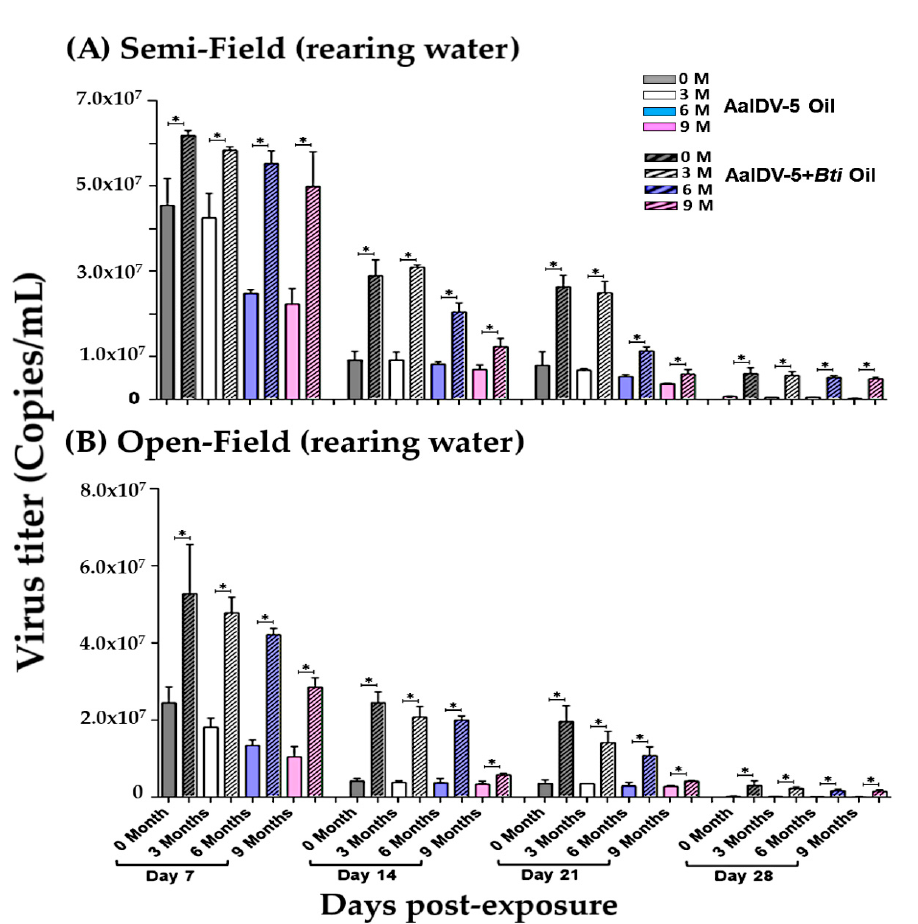
Figure 4. AalDV ‐ 5 quantification in larval rearing water. First instar Ae. albopictus larvae were ex ‐ posed with AalDV ‐ 5 oil and AalDV ‐ 5+ Bti oil (1 × 10 8 copies/mL) in 4 L of water, and virus titer in exposed with AalDV-5 oil and AalDV-5+ Bti oil (1 × 10 8 copies/mL) in 4 L of water, and virus titer in rearing water was determined on a weekly basis in semi ‐ field and open ‐ field conditions. ( A ) rearing water was determined on a weekly basis in semi-field and open-field conditions. ( A ) AalDV-5 AalDV ‐ 5 viral titer in semi ‐ field conditions. Virus titer was determined on days 7, 14, 21, and 28. ( B ) viral titer in semi-field conditions. Virus titer was determined on days 7, 14, 21, and 28. ( B ) AalDV-5 AalDV ‐ 5 viral titer in open ‐ field conditions. AalDV ‐ 5 titer was determined on days 7, 14, 21, and 28. viral titer in open-field conditions. AalDV-5 titer was determined on days 7, 14, 21, and 28. The error bars indicate SDs from three independent (biological) replicates ( n = 25 per replicate). The significance of the difference among the oil samples in different weeks was calculated by t -test using IBM SPSS ( A , B ), and the significant difference is indicated by * ( p <